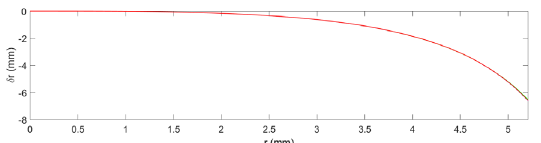
Figure 8. Ladybug5 radial lens distortion profiles for camera 0, Case